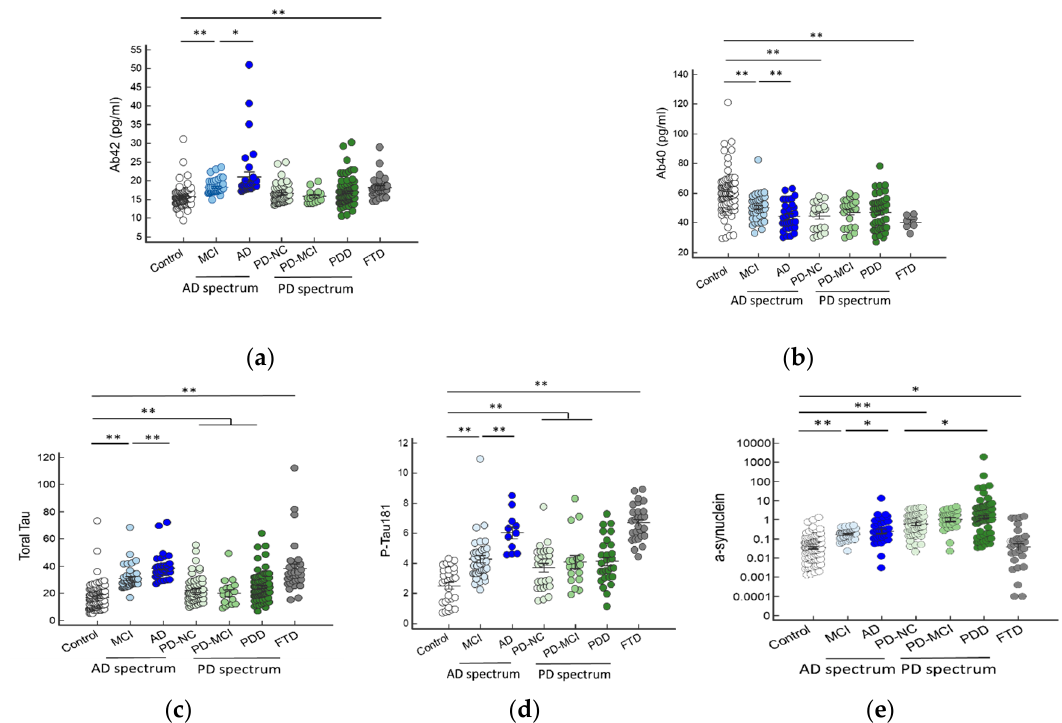
Figure 1. Individual plasma biomarker levels of normal controls and in different disease groups. The plasma A β 42 ( a ) and A β 40 ( b ) levels significantly increased in patients with AD and FTD, especially when compared to the normal control and other disease groups ( p < 0.01). The plasma total tau ( c ) and p -tau181 ( d ) level significantly increased in patients with FTD and then followed by AD, MCI, and PDD group ( p < 0.01). The plasma α -synuclein ( e ) levels were highest in the PDD group than other disease groups and controls. The mean ± one standard deviation (SD) was illustrated as horizontal lines in each disease group. * p < 0.05; ** p < 0.01.